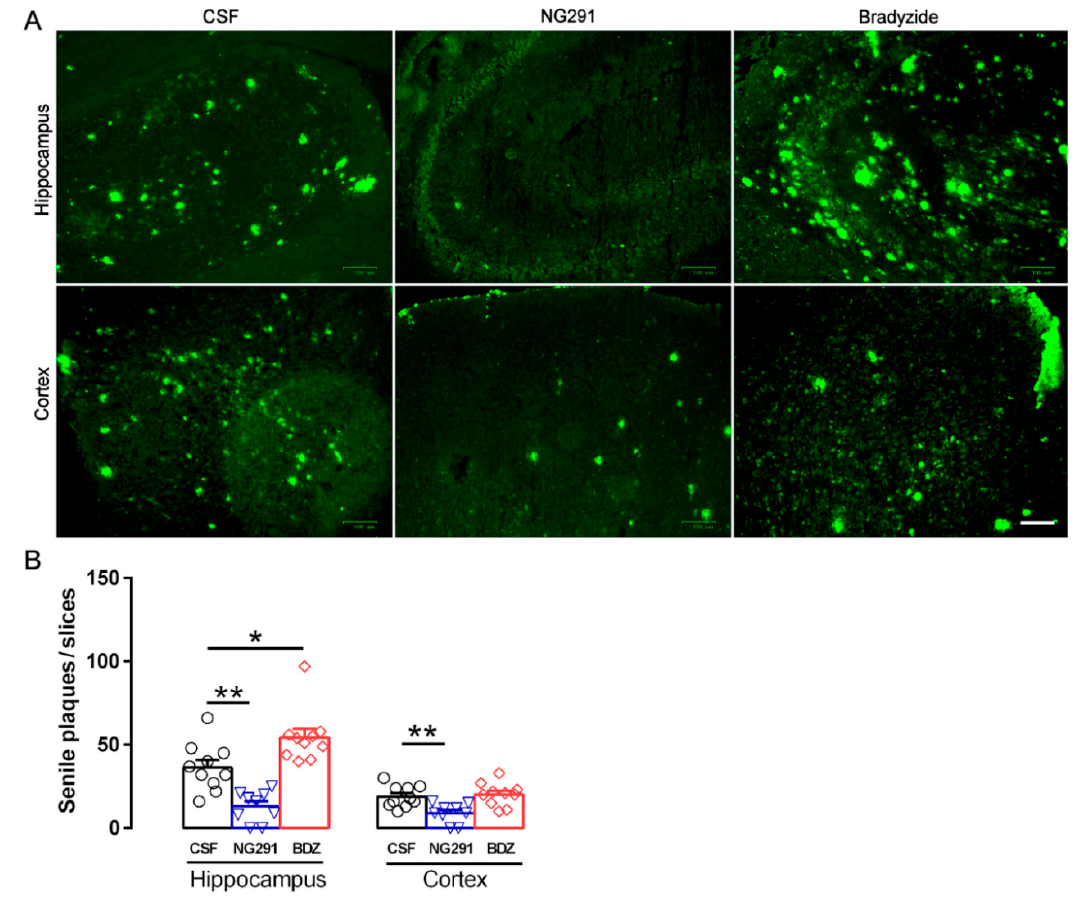
Figure 4. Activation of the B2R decreased the number of A β plaques. ( A ) Evaluation of amyloid plaques by the thioflavin-S method. ( B ) Transgenic animals treated with B2R agonist showed less plaque when compared to untreated TG animals. NG291—B2R agonist; BDZ—B2R antagonist. Data were analyzed with one-way ANOVA followed by Dunnett’s multiple comparison test. * p < 0.05, ** p < 0.01. Scale bar is 100 µm. CSF ( n ) = 10, NG291 ( n ) = 9, BDZ ( n ) = 10.